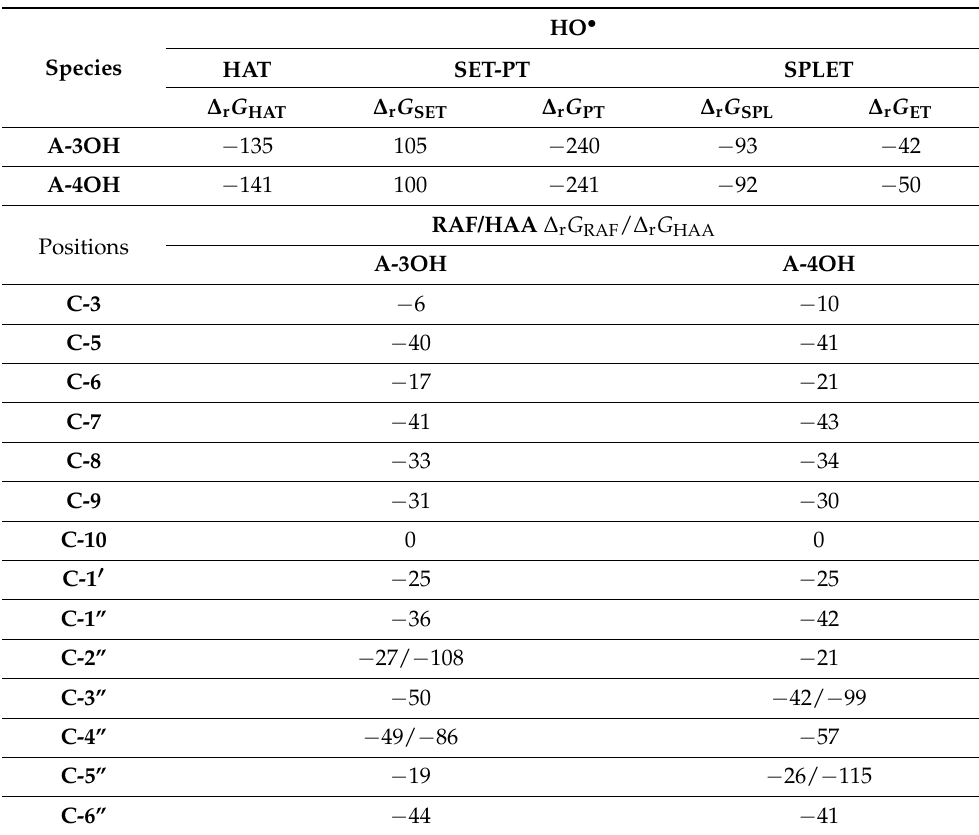
Figure 4. Optimized geometry of investigated compounds at M06-2X/6-311++G(d,p) level of theory. Table 1. Estimated values of Gibbs reaction energies ( ∆ r G ) in kJ mol − 1 for reactions between newly coumarin derivatives and HO •